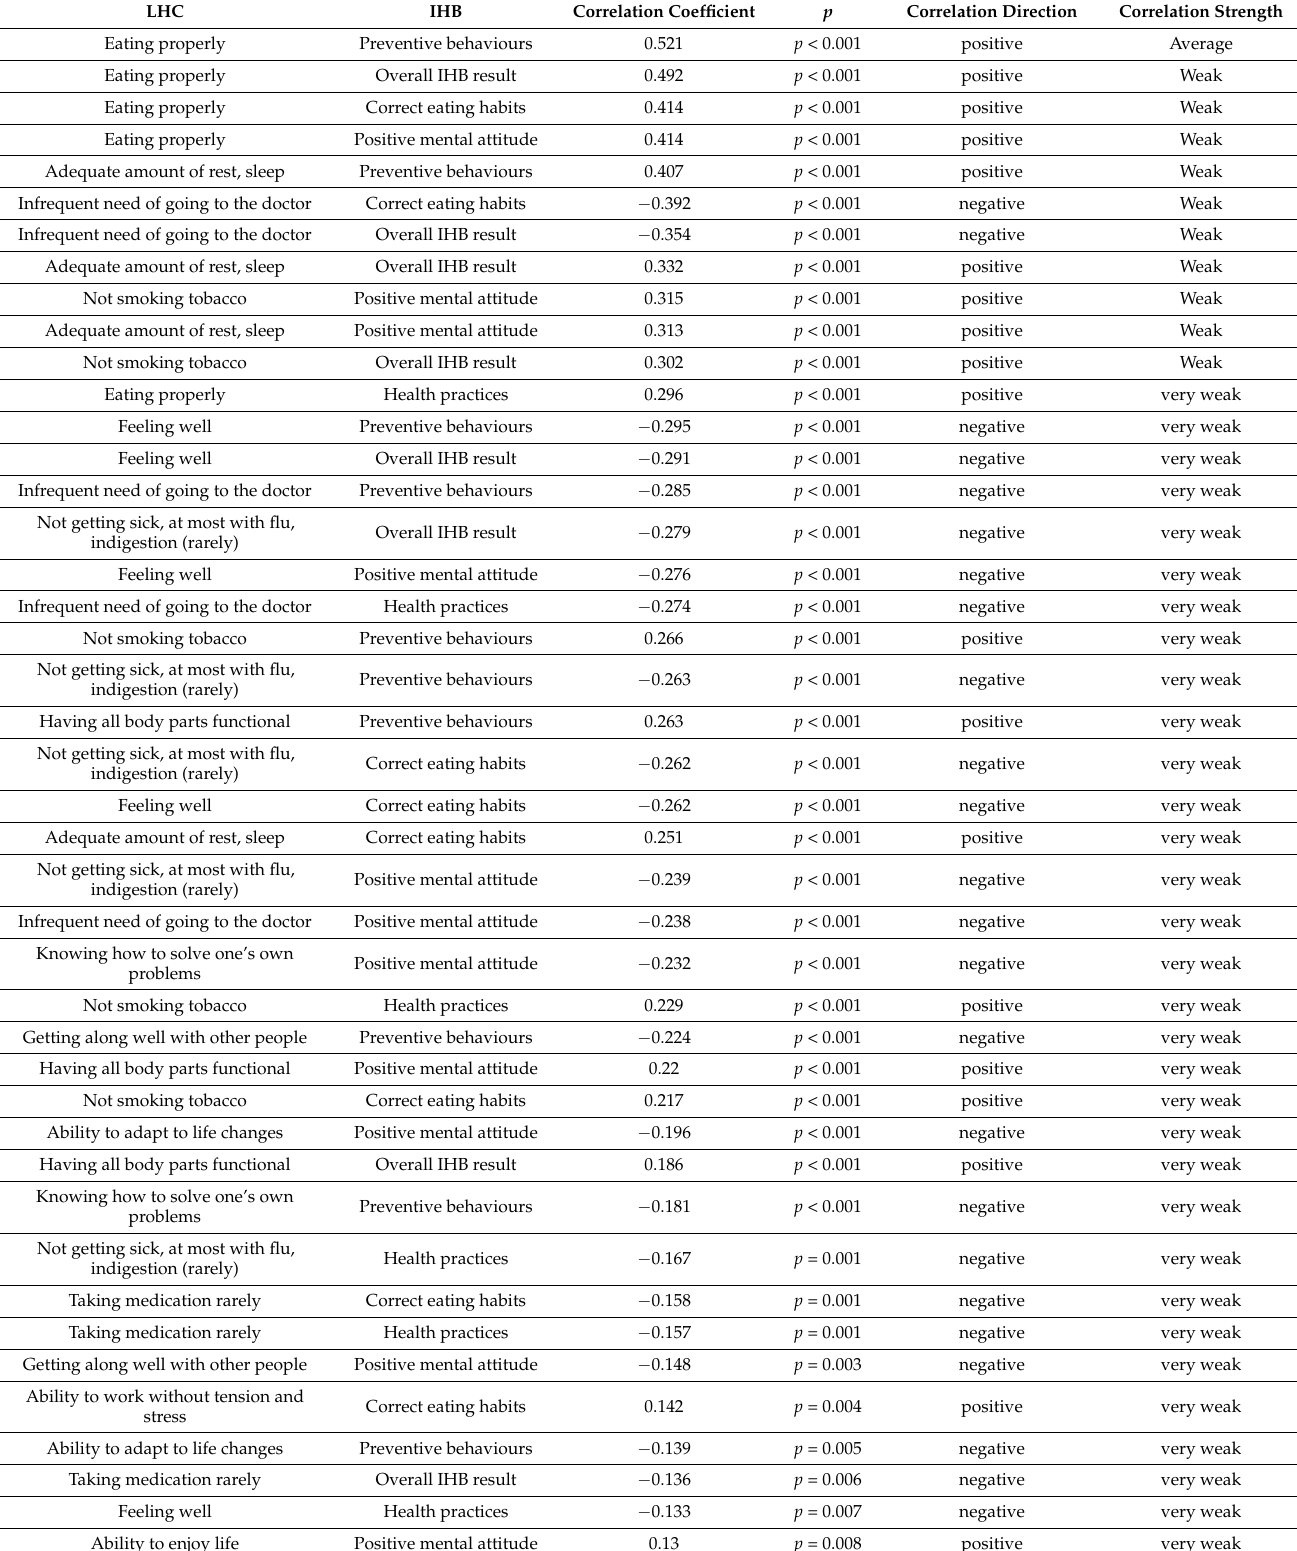
Table 11. The level of health behaviours according to the Inventory of Health-Related Behaviour (IHB) versus number of selections of individual categories of the List of Health Criteria